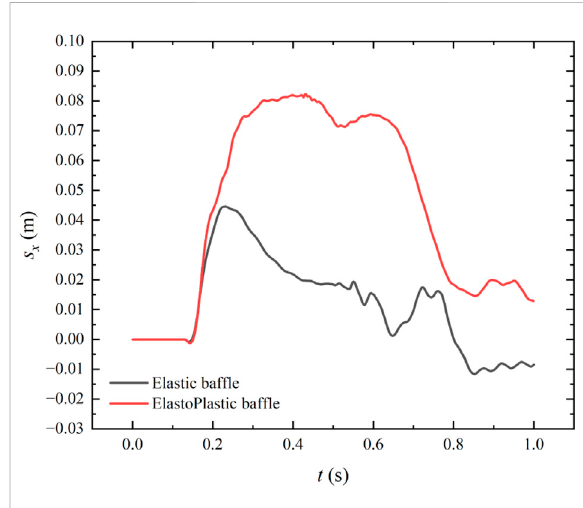
The time history of horizontal displacement of the upper left corner of the elastic/elastoplastic baf fl